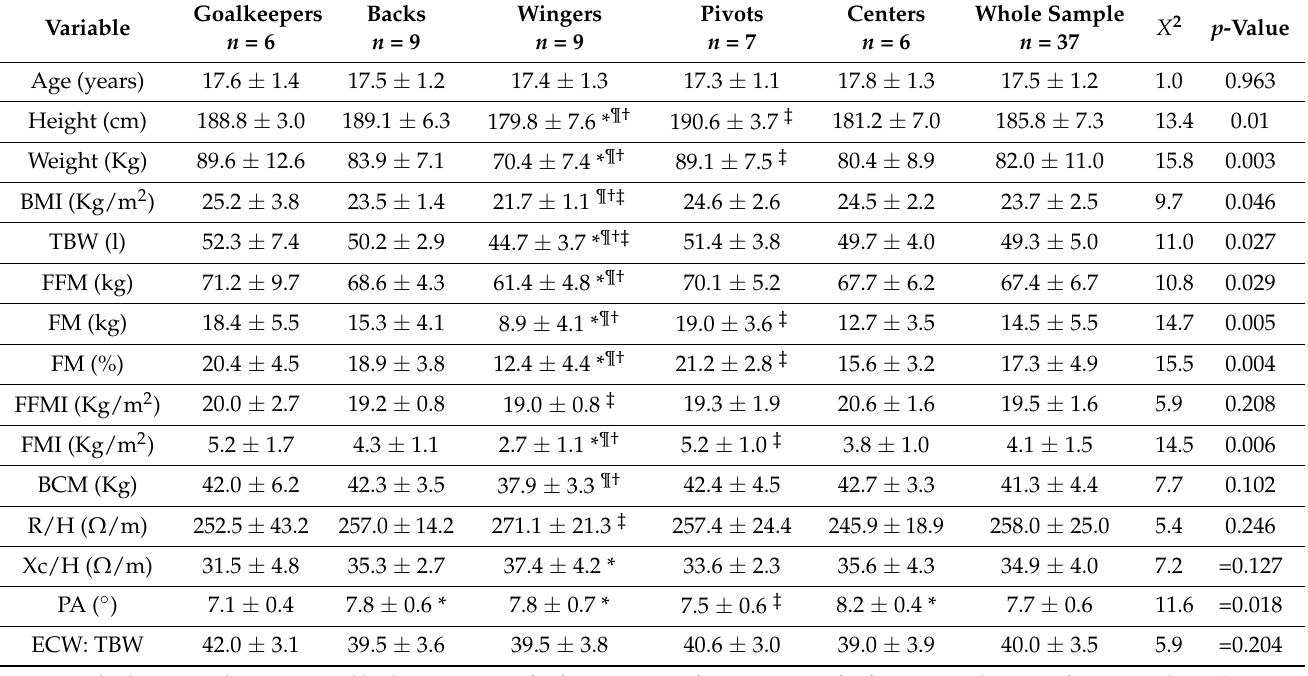
The BIVA point graph (Figure 1a,b) indicates that young handball players mainly fell outside the 75% tolerance ellipse regardless of age or sex; they were outside the 95% tolerance ellipse in many